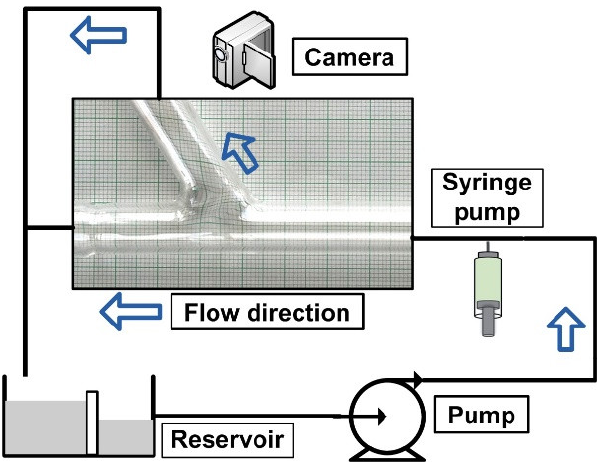
Figure 1. Experimental setup design.